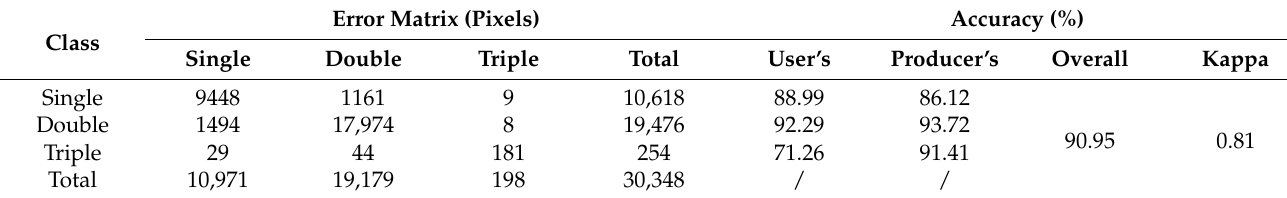
Table 1. Accuracy assessment of cropping intensity classification in the study